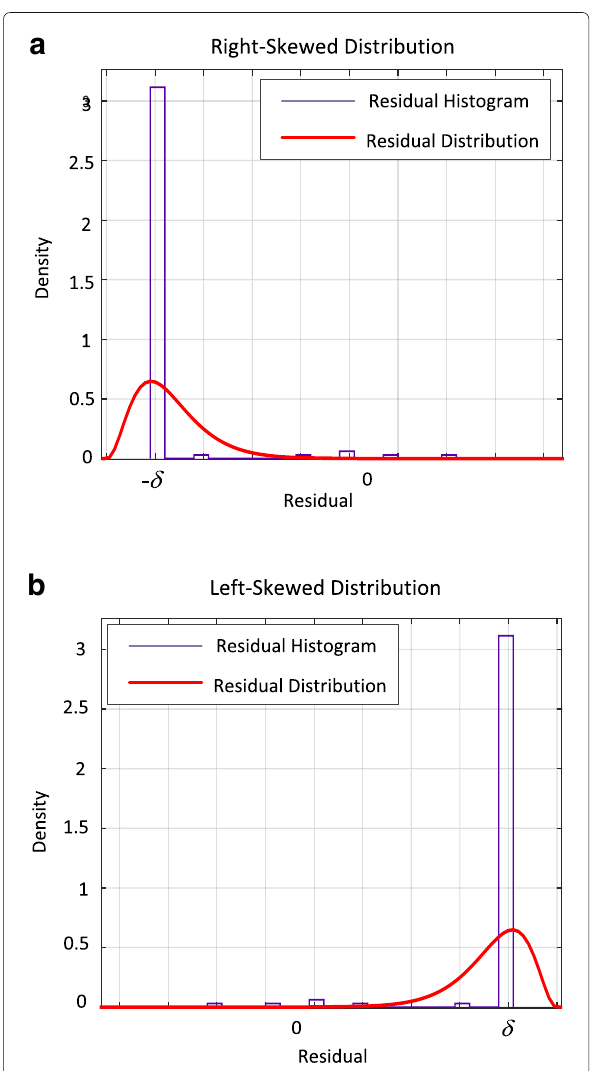
Fig. 5 The right-skewed ( a ) and left-skewed ( b ) residual distributions. The purple line and red line denote the residual histogram and the fitted residual distribution,